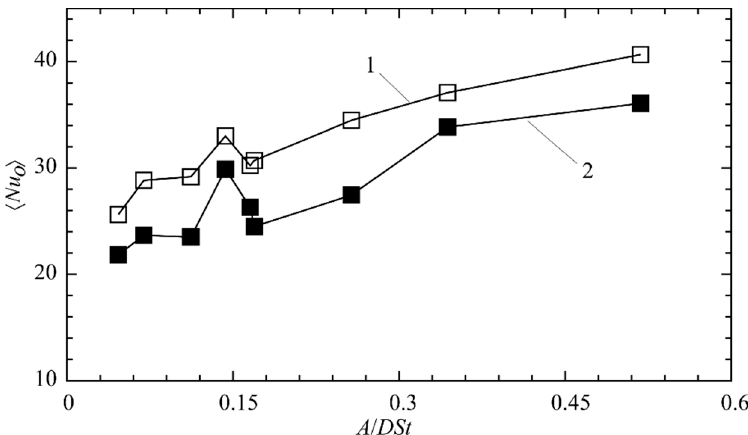
Figure 7. Variation of Nu o with A / DSt : 1—experimental data [42]; 2—numerical simulation.